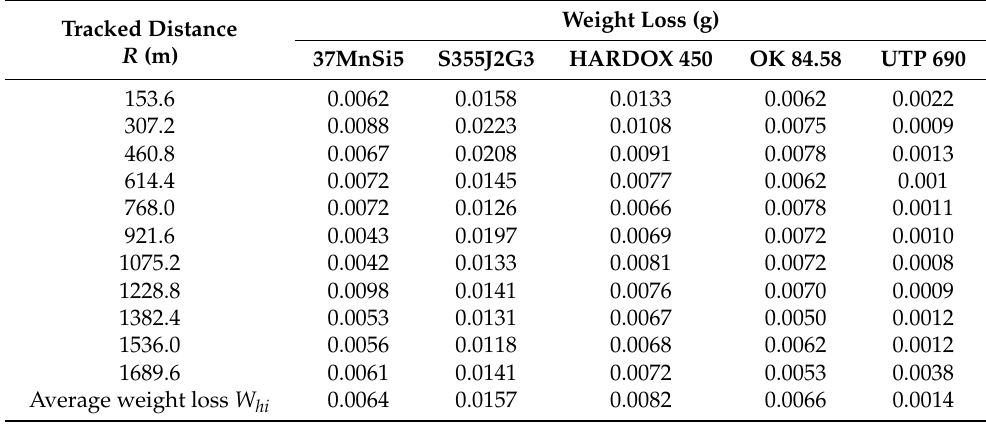
Table 6. Average weight losses of 37MnSi5, S355J2G3, HARDOX 450 steels and OK 84.58 and UTP 690 hardfacing materials.